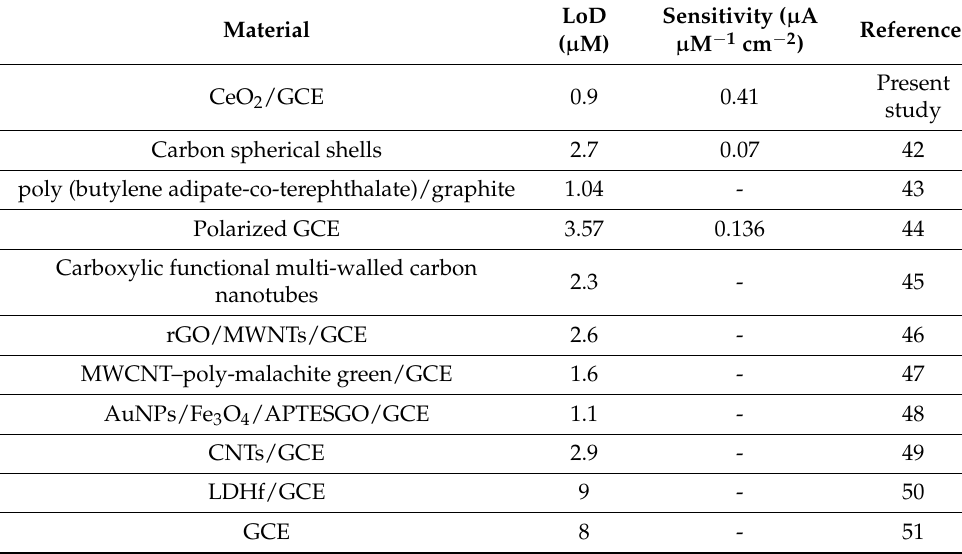
Table 1. Comparison of LoD of CeO 2 /GCE with previous reports [42–51].